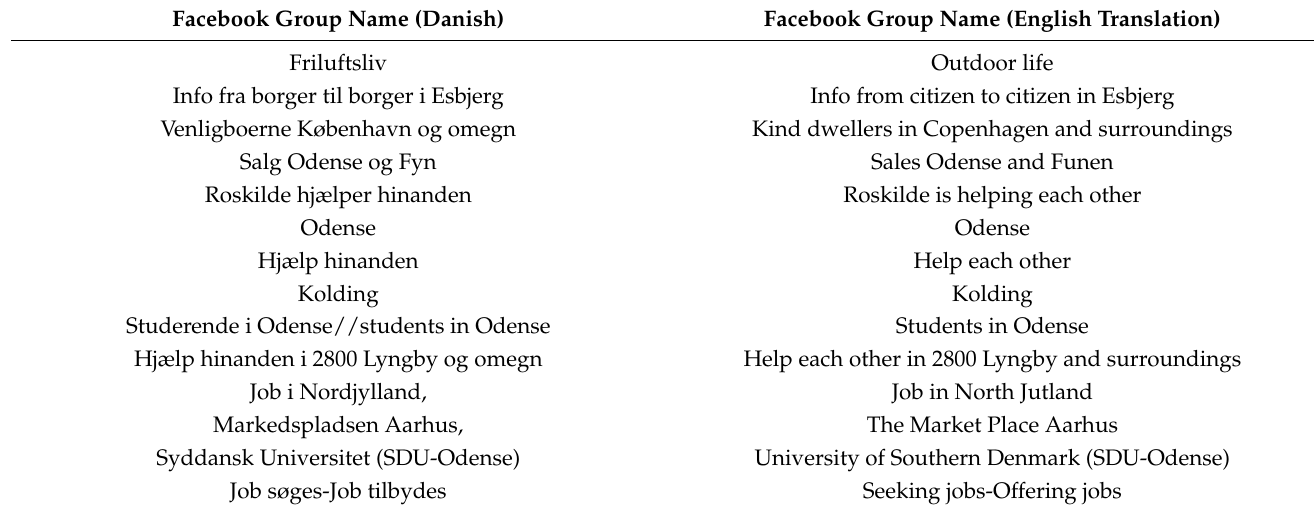
Table 1. Examples of Facebook groups used for recruiting respondents in March